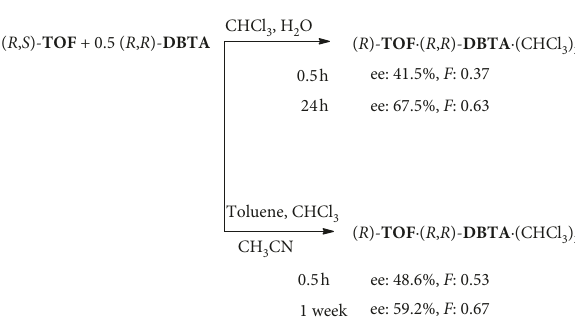
Scheme 8: The thermodynamic control is more favourable. Minor conformer partially dissolves, while the stable form accumulates (see Section